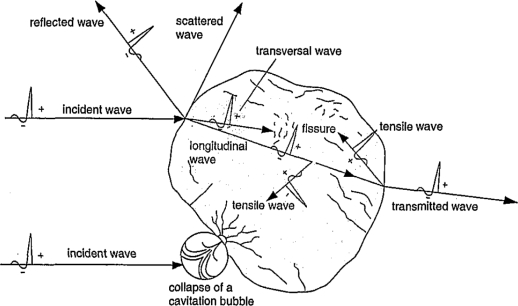
Scheme of the disintegration of a kidney stone as a result of direct and indirect shock wave effects. Figure adapted from [235] with permission.